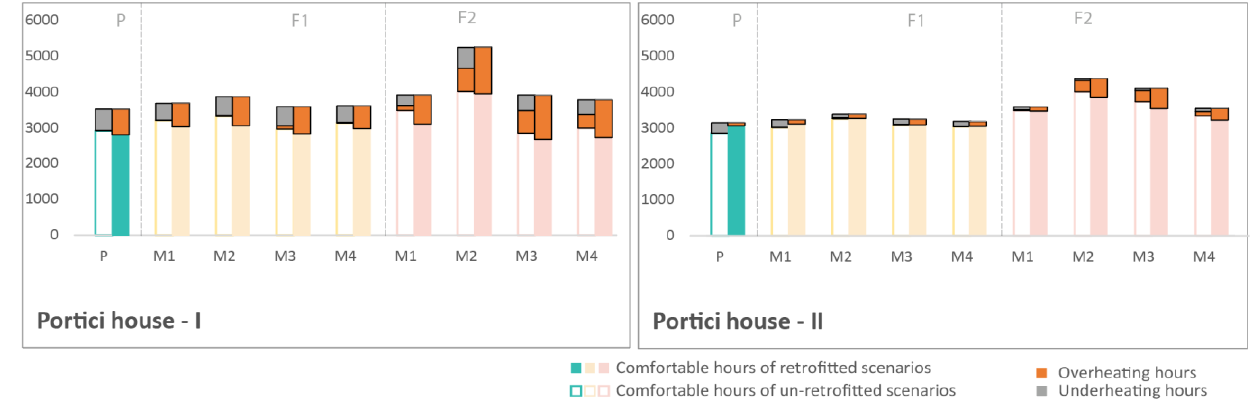
Figure 11. Thermal comfort state in the Livingroom of Portici house-I ( left ) and Portici house-II ( right ) according to adaptive thermal comfort model of EN15251. P = 2008 – 2018, F1 = 2041 – 2050, and F2 = 2091 – 2100; M1 – 4 refer to the climate models in Table 2.